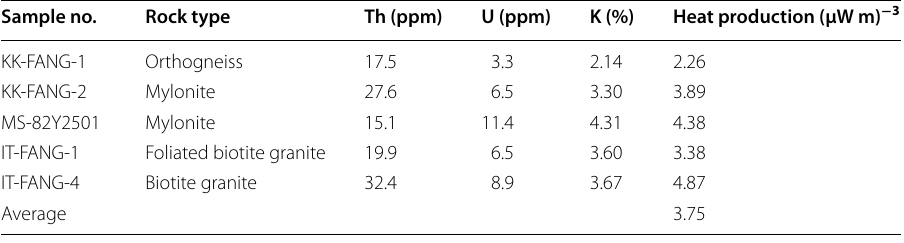
Sample numbers and analysis are from Kawada et al. (1987) Heat production ( A , µW m − 3 ) calculation uses the formula from Jaupart et al. (2016): A where U and Th are in ppm, and K is in % by weight